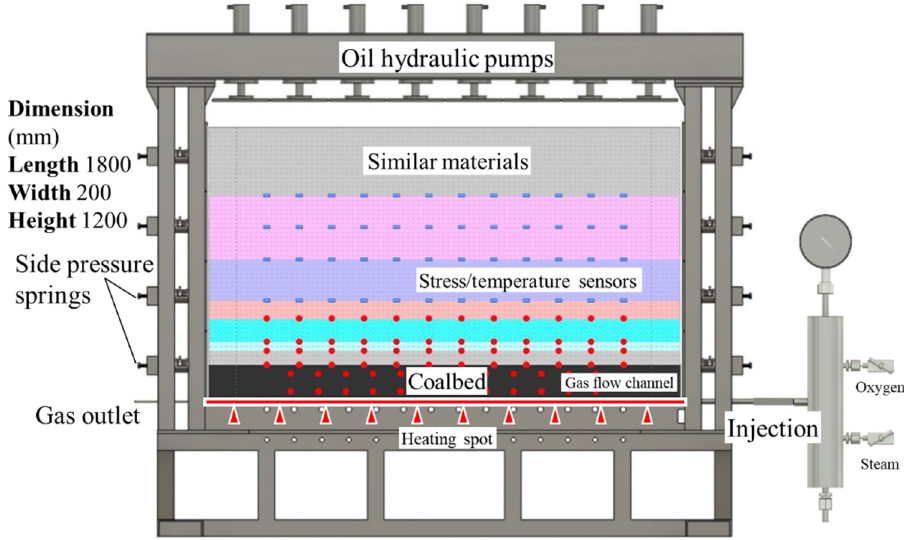
Figure 2. Frame parameters, loading devices and connection of combustion devices.